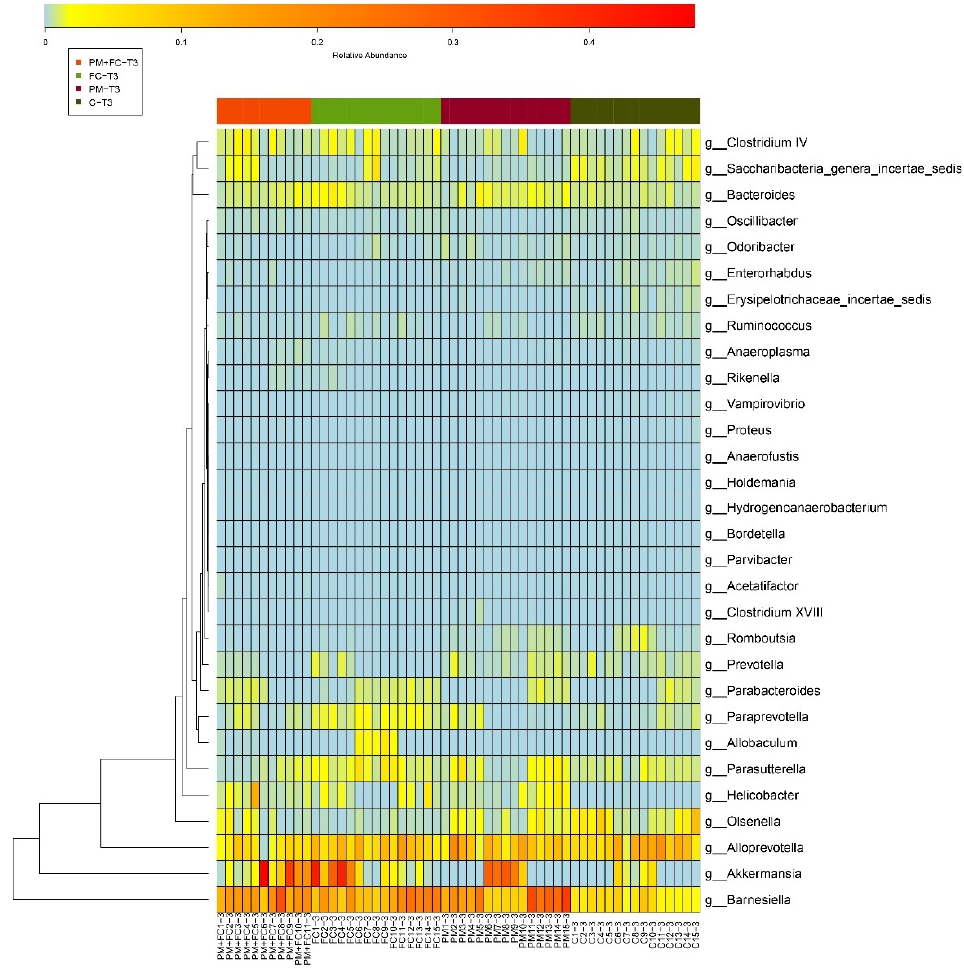
Figure 12. Heatmaps and clustering of individual samples for gut microbiota taxonomic composition.